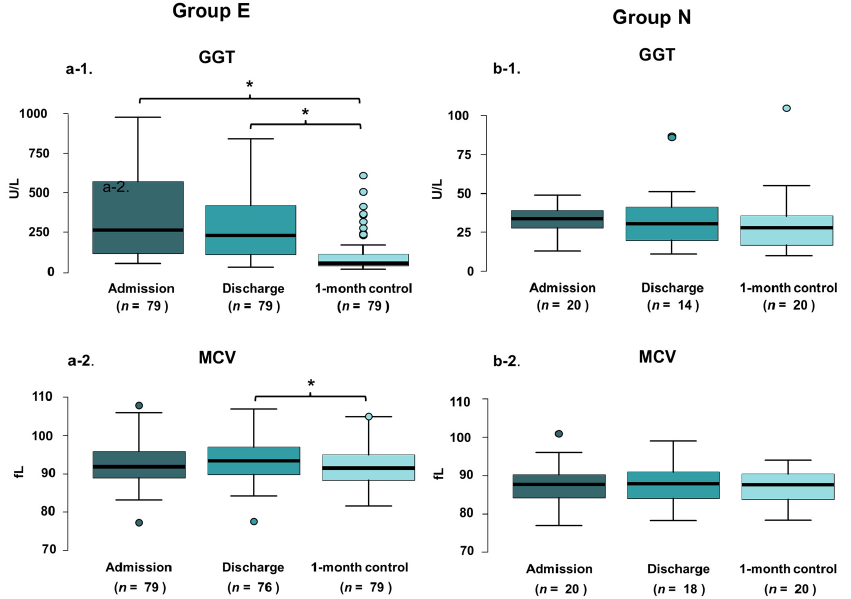
Figure 1. GGT and MCV values of patients in Groups E and N in different time points visualized by boxplots. E-patients with elevated on-admission GGT level ( a ); N-patients with non-elevated on-admission GGT level ( b ); GGT—gamma-glutamyltransferase; MCV—mean corpuscular volume. * p < 0.001.